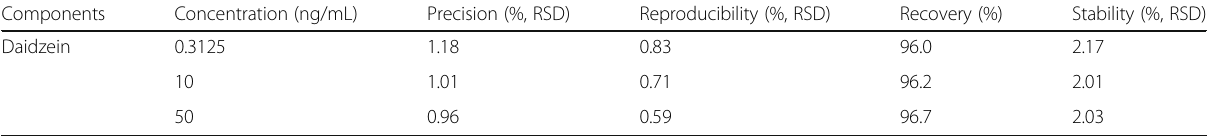
Table 1 Precision, reproducibility, recovery, and stability of daidzein detected by HPLC method ( n = 6)